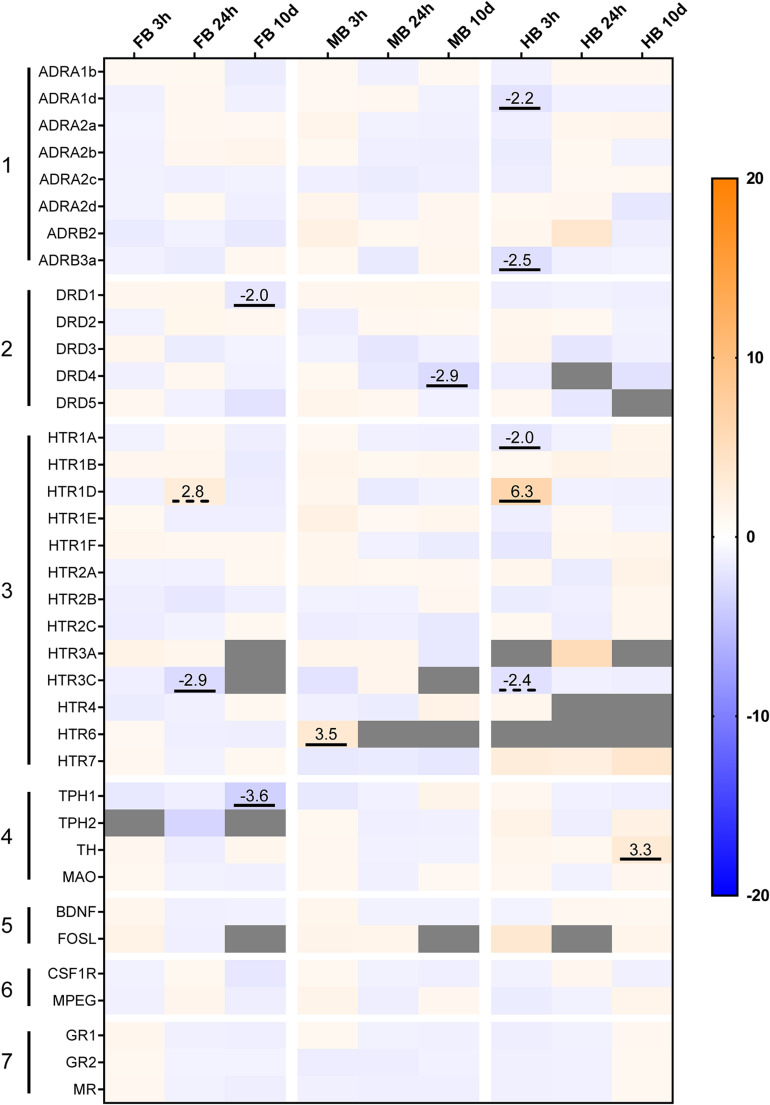
Heatmap illustrating the effects of acute and chronic handling on gene expression in the brain of maraena whitefish. The heatmap shows the gene expression in fold-change values in the different brain sections after acute (3 and 24 h) and chronic (10 days) handling stress. The transcript level of each gene (n = 6) in the different brain sections and time-points was compared to its corresponding control group (n = 6 each). The scale bar indicates up-regulation (orange) or down-regulation (blue). Gray cells indicate non-detectable expression. The gene groups comprised (1) adrenergic receptor genes; (2) dopamine receptor genes; (3) 5-HT receptor genes; (4) monoamine synthesis genes; (5) neuronal activity markers; (6) microglial markers; (7) cortisol receptor genes. Genes were considered significantly regulated in the event of either an (at least) twofold up- or down-regulation of the transcript concentration and a p-value < 0.05 (marked by an underline) or non-significant tendencies at 0.05 < p < 0.10 (are marked with dashed lines).